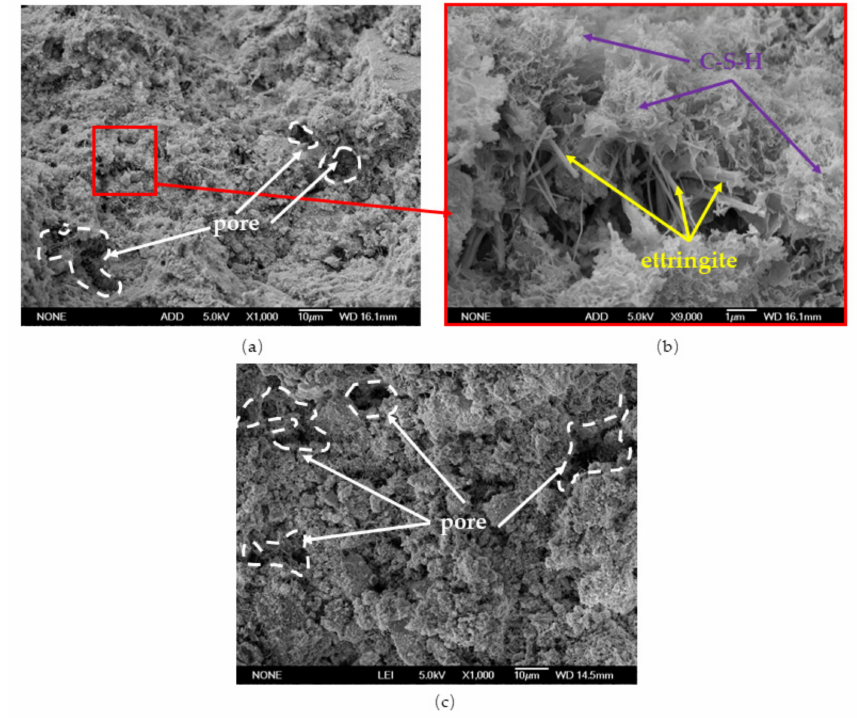
Figure 6. SEM images of MSGB and cement at 7 d curing age. ( a ) MSGB-X1000. ( b ) MSGB-X9000. ( c ) cement-X1000.